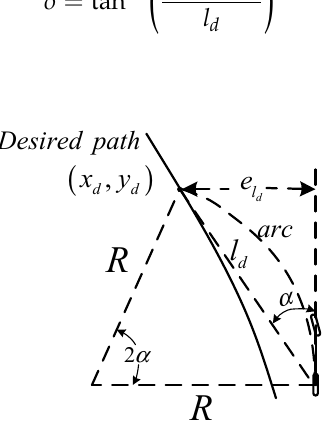
Figure 6. Pure pursuit geometry.